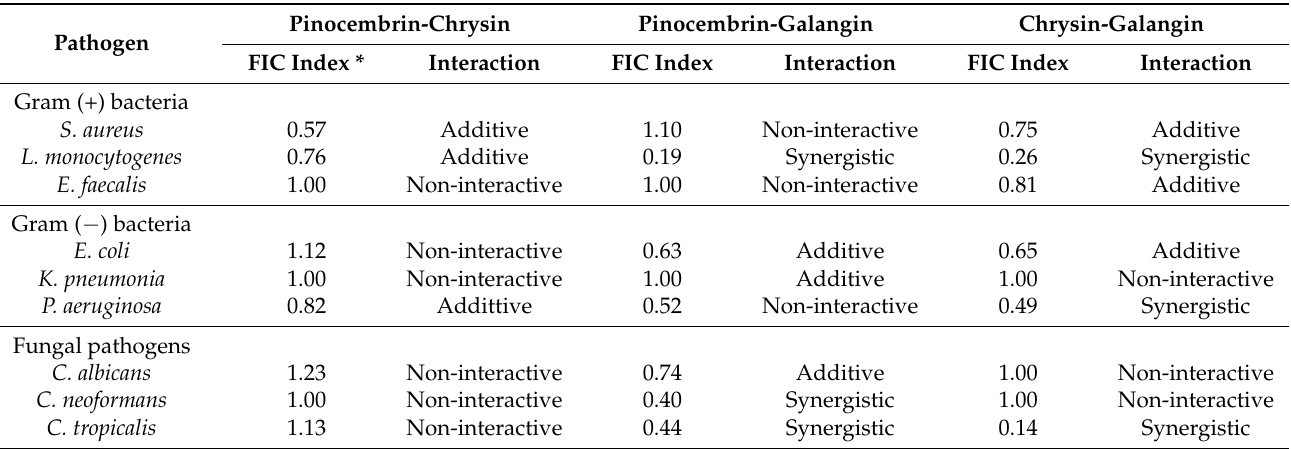
Table 1. Combination effects of propolis’s flavonoids against nine pathogens. Reprinted with permission from Ref. [63]. Permission to use the data has been obtained from Elsevier,